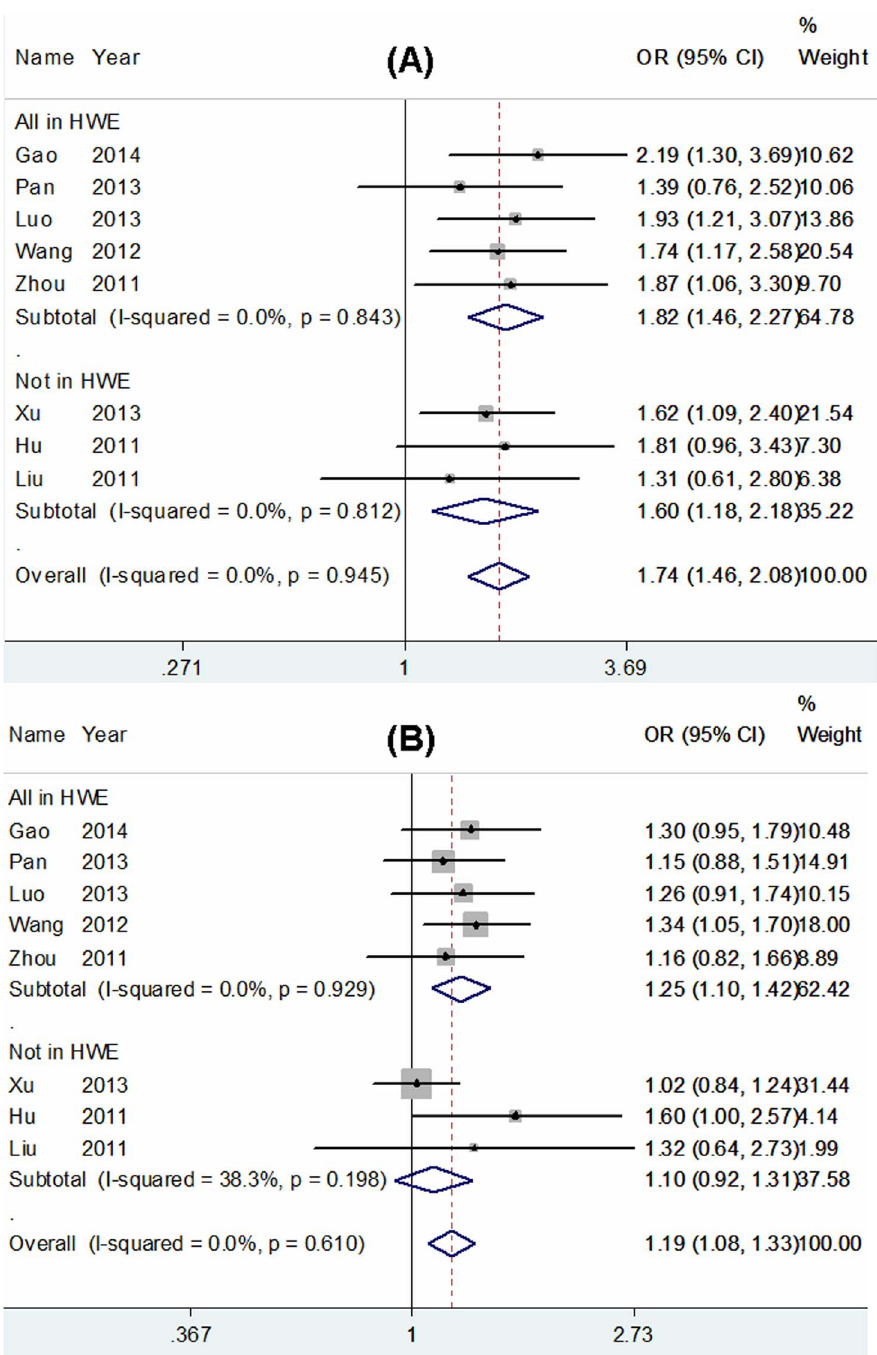
Figure 2. Forest plots of ORs with 95% CI for XRCC1 Arg399Gln polymorphism and the risk of glioma observed in Chinese population (fixed effects). The center of each square represents the OR, the area of the square is the number of sample and thus the weight used in the meta-analysis, and the horizontal line indicates the 95%CI. (A) Gln/Gln vs. Arg/Arg. (B) Arg/Gln vs. Arg/Arg.